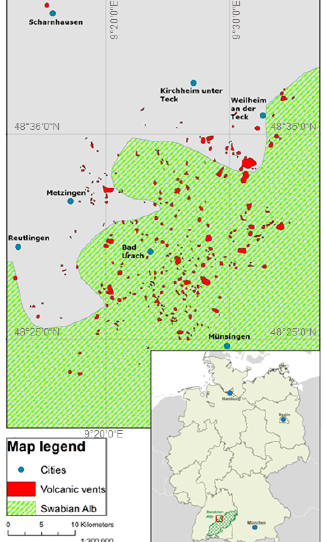
Figure 5. Swabian volcano (Author’s design, based on Data from [59]).